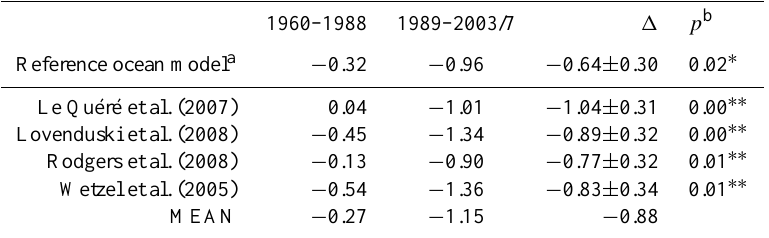
Table 1. The mean of net land uptakes for the periods 1960–1988 and 1989–2003/7 and the difference 1 =1989–2003/7 minus 1960– 1988 using each of the ocean models shown in Fig. 1b. The net land uptake numbers are calculated from the annual means to remove the autocorrelation.